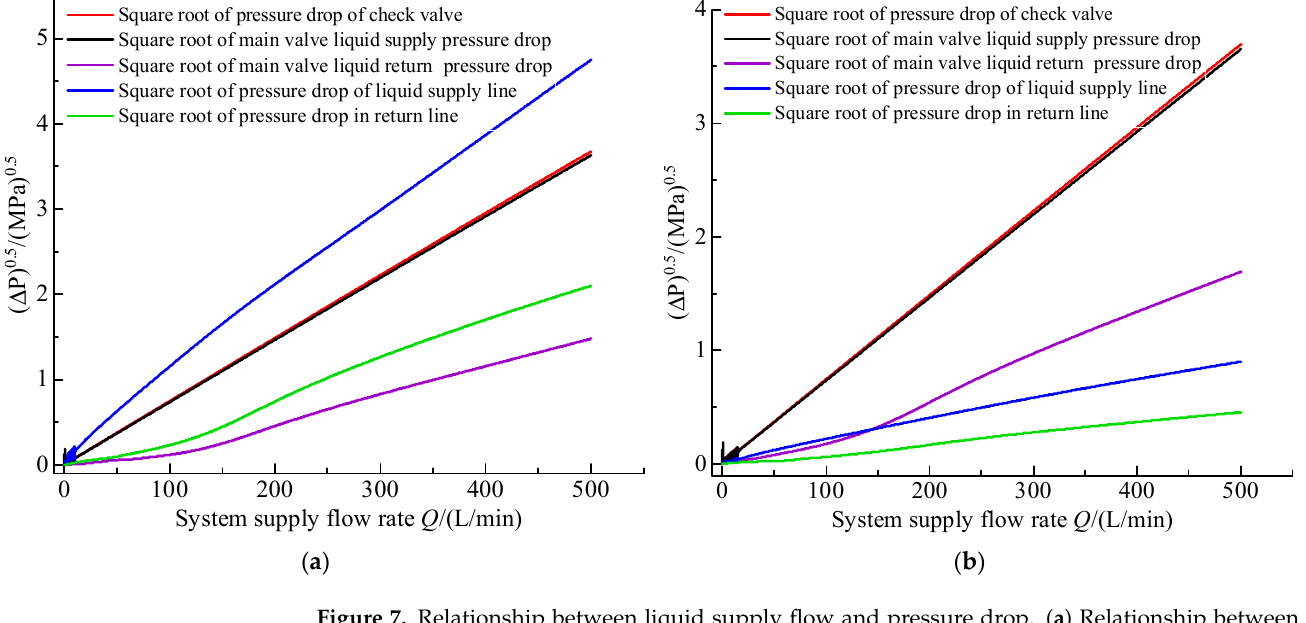
Figure 7. Relationship between liquid supply flow and pressure drop. ( a ) Relationship between liquid supply flow of DN10 pipeline and square root of pressure drop; ( b ) relationship between liquid supply flow of DN20 pipeline and square root of pressure drop.